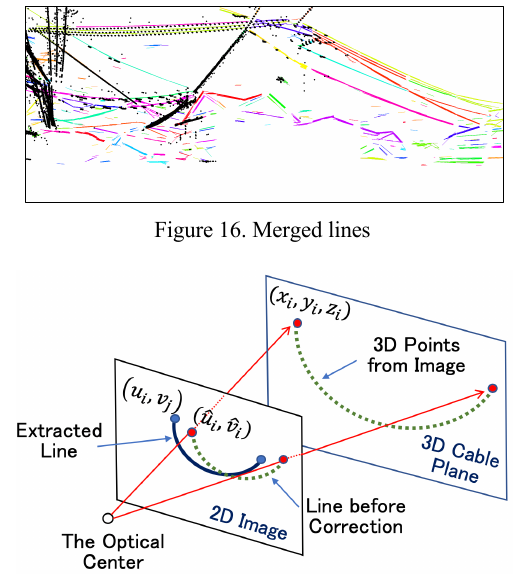
Figure 17. Projection of pixel point onto 3D plane